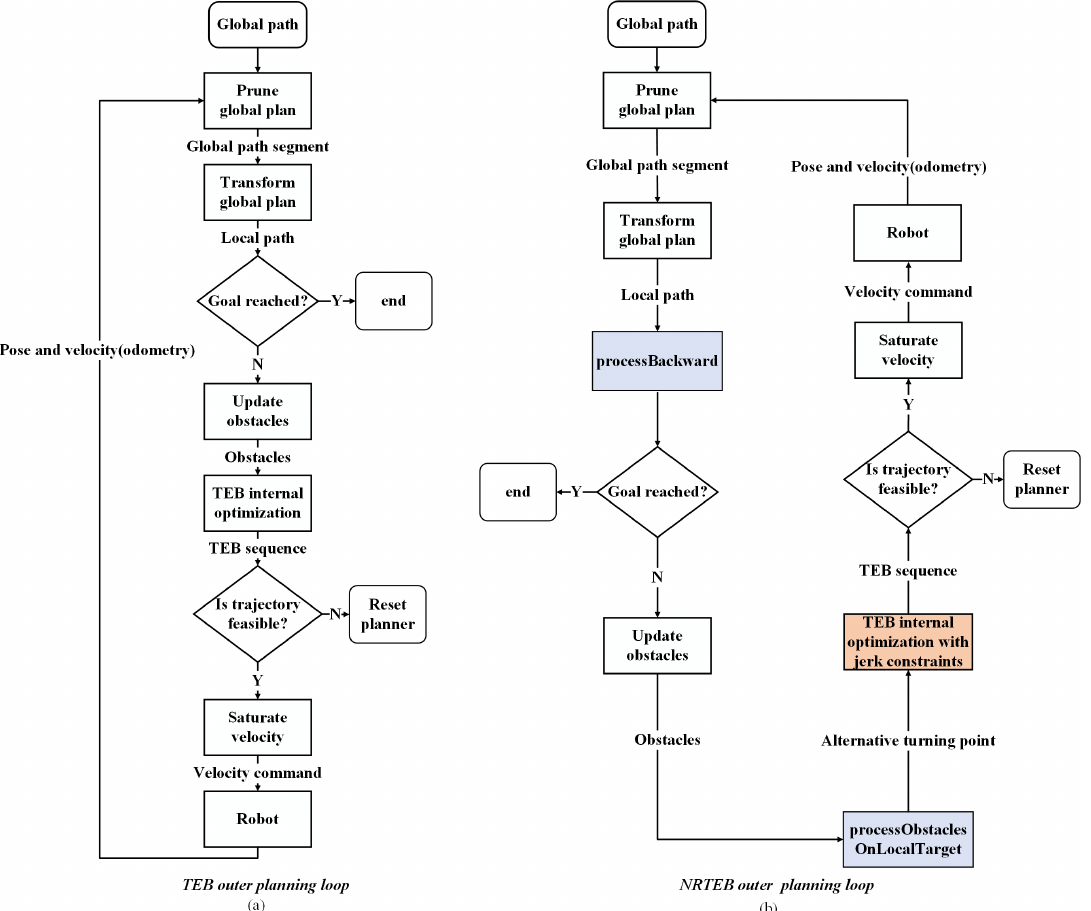
Figure 1. Workflow comparison. ( a ) is the workflow of the TEB method. ( b ) is the NRTEB workflow. The two modules in blue represent improvements in the outer planning loop, corresponding to contributions 3 and 4. The orange module represents improvements in the inner planning loop, corresponding to contribution